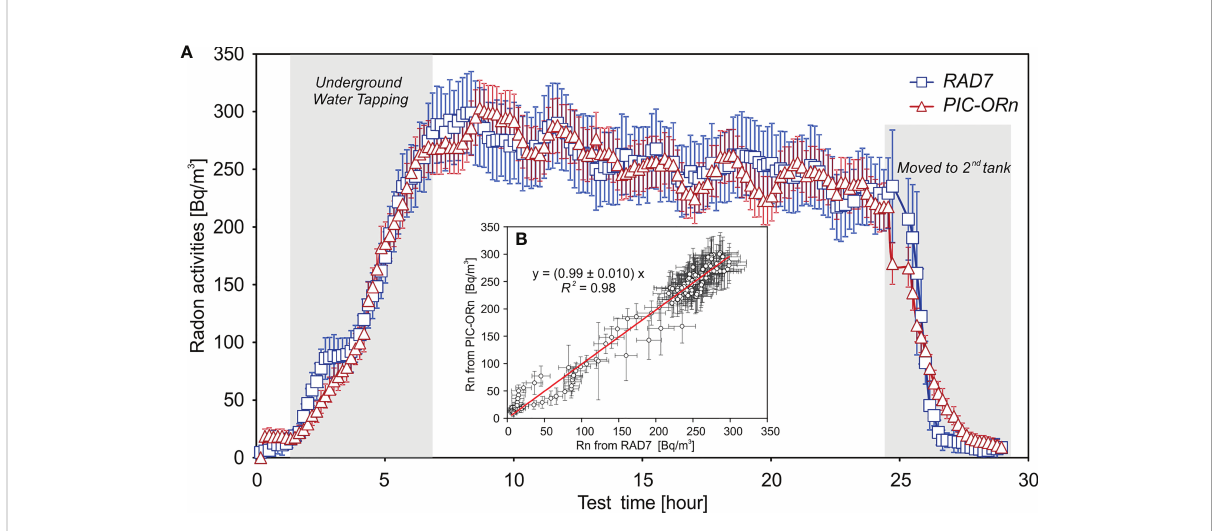
Scatter plot of the radon-in-water activities measured by the PIC-ORn versus the RAD7. The error bars represent the 1- s uncertainties based on counting